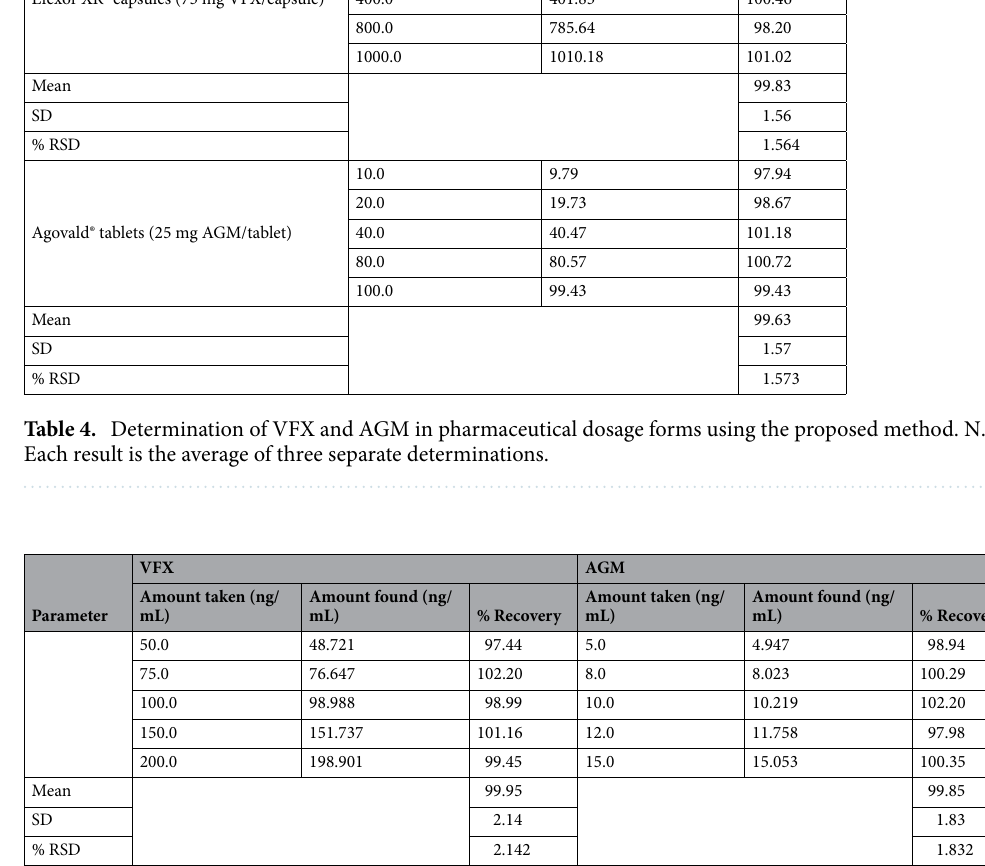
Table 5. Application of the proposed method for the determination of the studied drugs in spiked human plasma samples. N.B. Each result is the average of three separate determinations.